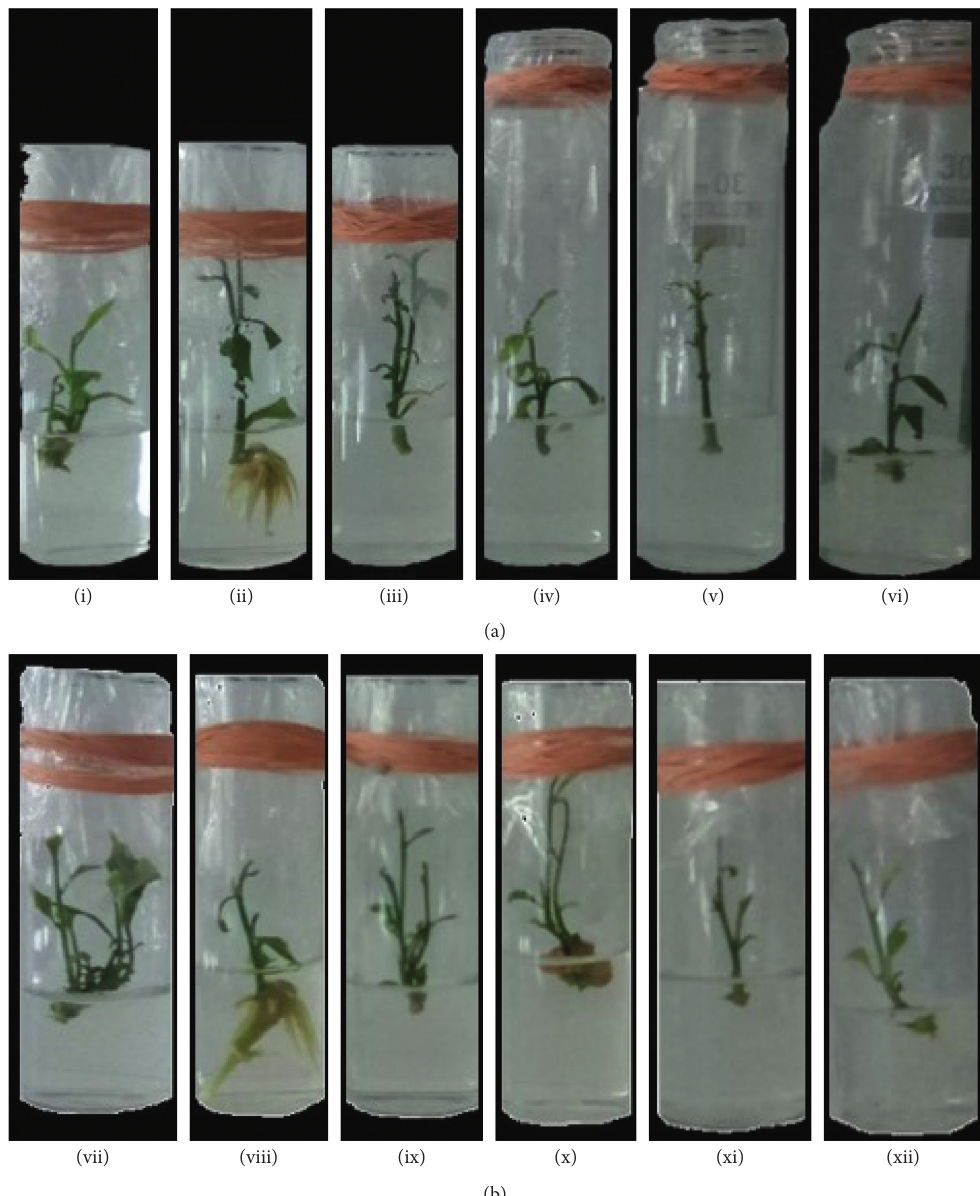
Figure 5: A set of representative cultures showing the effect of N hormone and sugar on rooting. (a) MS (i, no hormone and 3% sugar; ii, 1mg/l NAA and 3% sugar; iii, 1 mg/l IBA and 3% sugar; iv, no hormone and 6% sugar; v, 1mg NAA and 6% sugar; and vi, 1mg IBA and 6% sugar); (b) ½MS (vii, no hormone and 3% sugar; viii, 1mg/l NAA and 3% sugar; ix, 1 mg/l IBA and 3% sugar; x, no hormone and 6% sugar; xi, 1mg NAA and 6% sugar; and xii, 1mg IBA and 6%